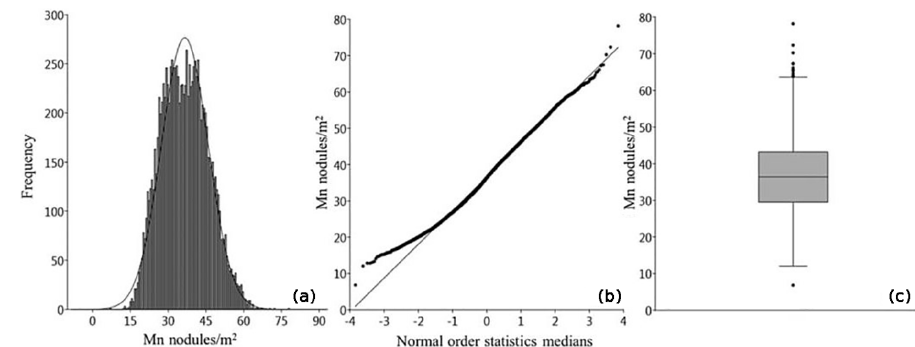
Figure B1. (a) Histogram of Mn nodules m − 2 with the superimposed normal curve. (b) The normal probability plot of Mn nodules m − 2 . (c) The box plot of Mn nodules m − 2 .